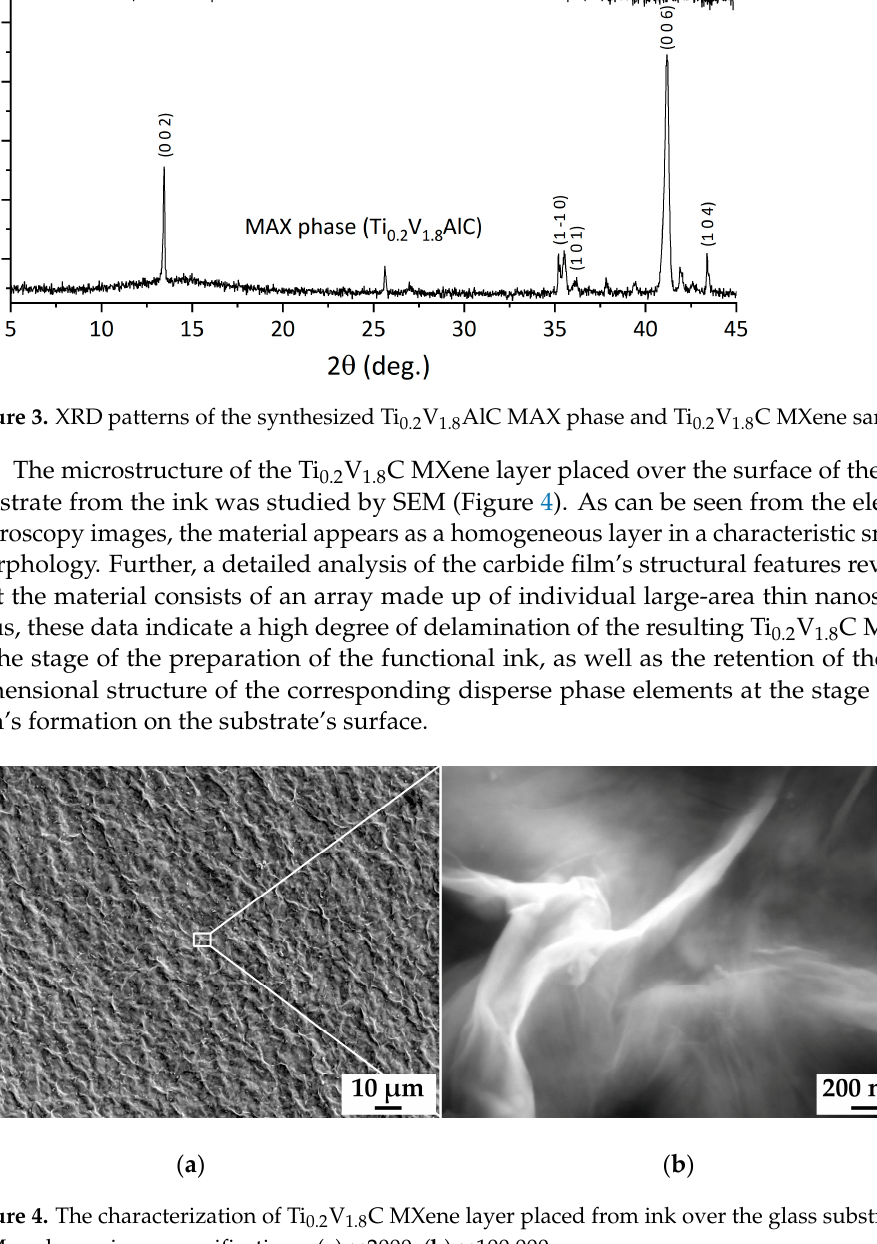
Figure 4. The characterization of Ti 0.2 V 1.8 C MXene layer placed from ink over the glass substrate by SEM under various magnifications: ( a ) ×2000, ( b ) ×100,000.